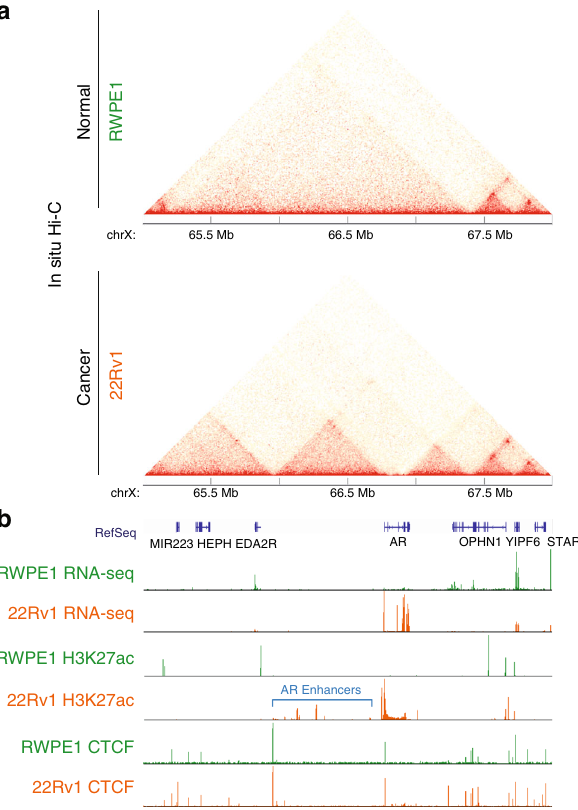
Fig. 6 Chromatin structure changes surrounding the AR locus in prostate cancer cells. a In situ Hi-C chromatin interaction maps of normal (RWPE1) and prostate cancer (22Rv1) cells for the region surrounding the AR locus. b RNA-seq, H3K27ac, and CTCF ChIP-seq tracks of normal (RWPE1) and prostate cancer (22Rv1) cells for the AR locus. The potential AR enhancers within the TAD where AR promoter resides are shown in a blue